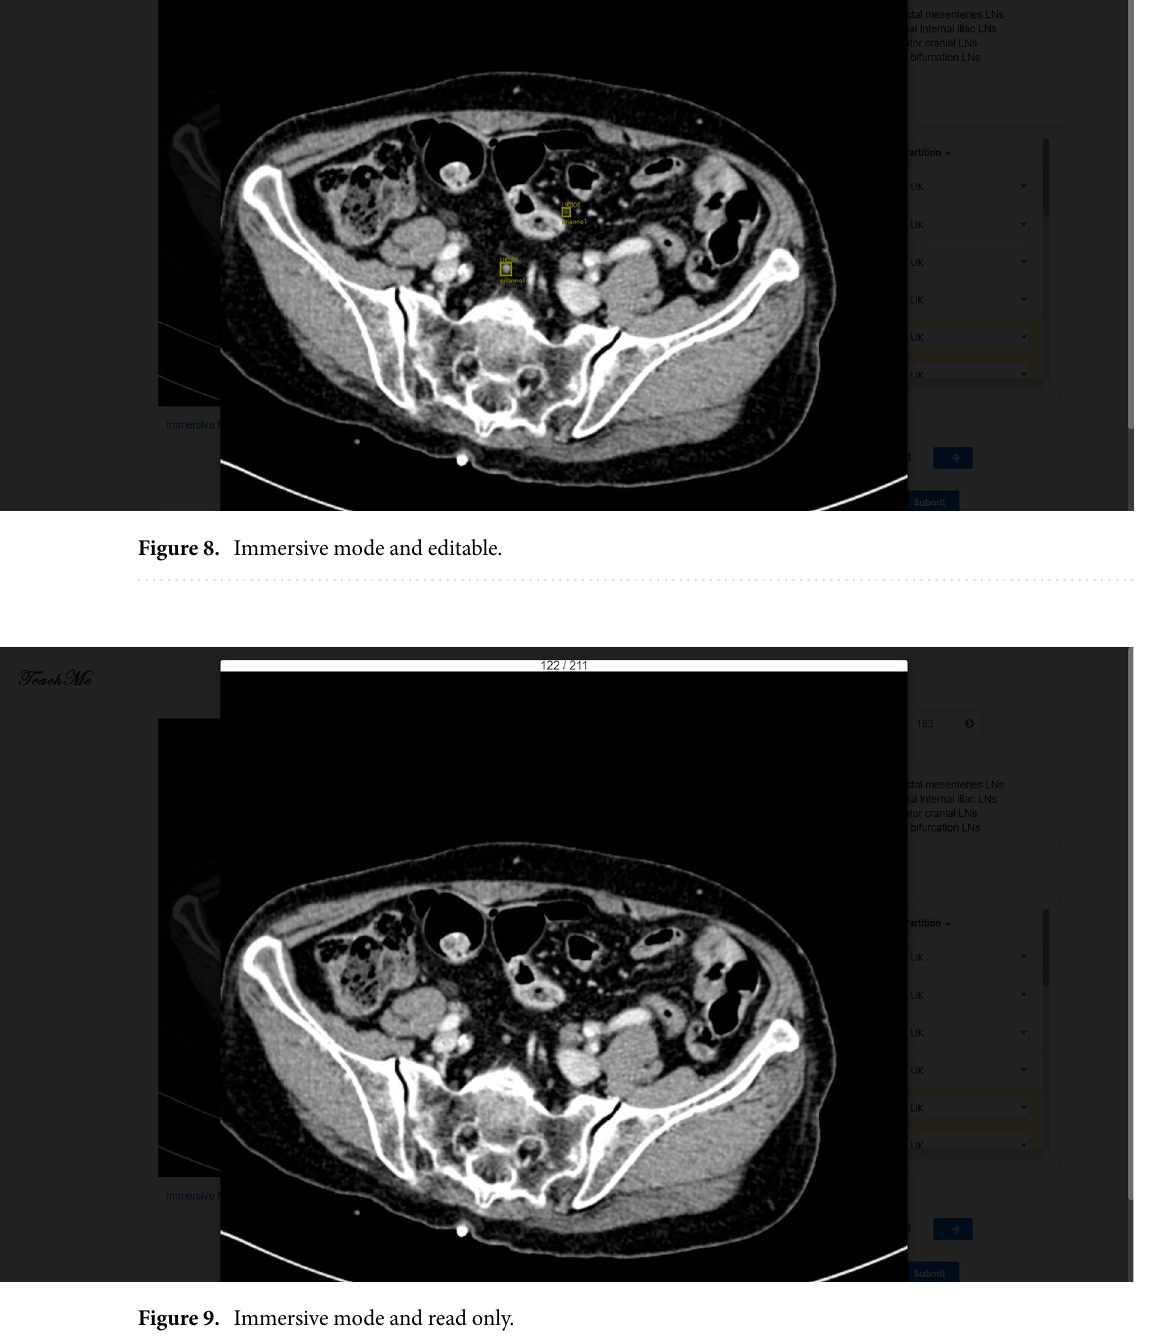
Figure 9. Immersive mode and read